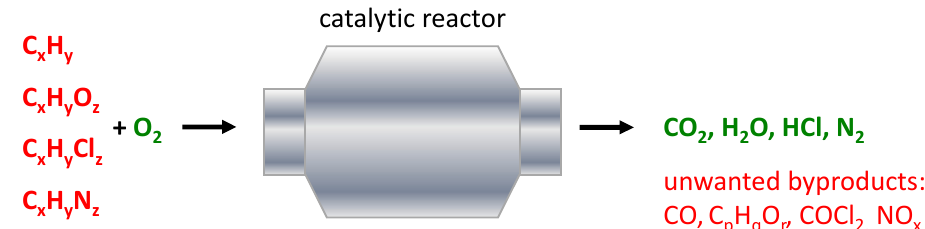
Figure 7. Schematic illustration of catalytic combustion of VOCs.